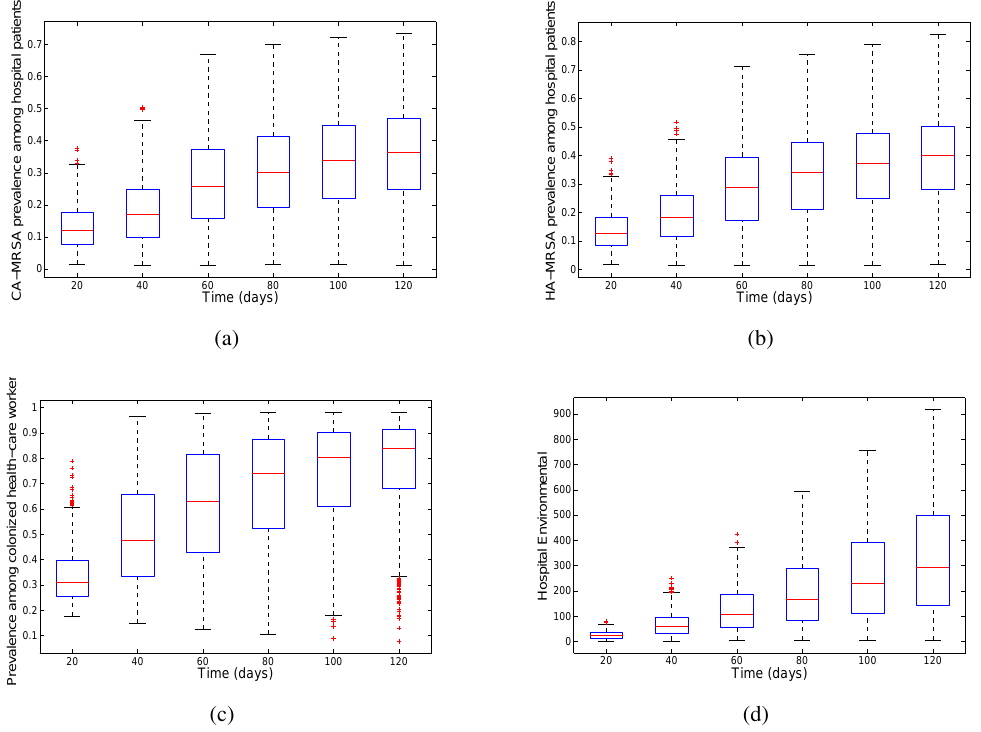
Fig. 3. (a). Boxplots of prevalence of CA-MRSA among patients; (b). Boxplots of prevalence of HA-MRSA among patients; (c). Boxplots of prevalence of MRSA among health-care workers; (d). Boxplots of the hospital